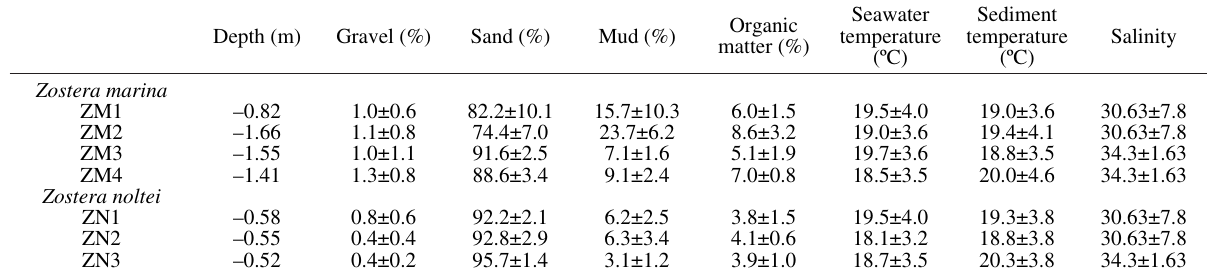
Table 1. – Mean annual±standard deviation (2000-2001) for grain size fractions (%), organic matter (%), water and sediment temperature (ºC), and salinity (psu) in the Zostera marina (ZM1-ZM4) and Zostera noltei (ZN1-ZN3)